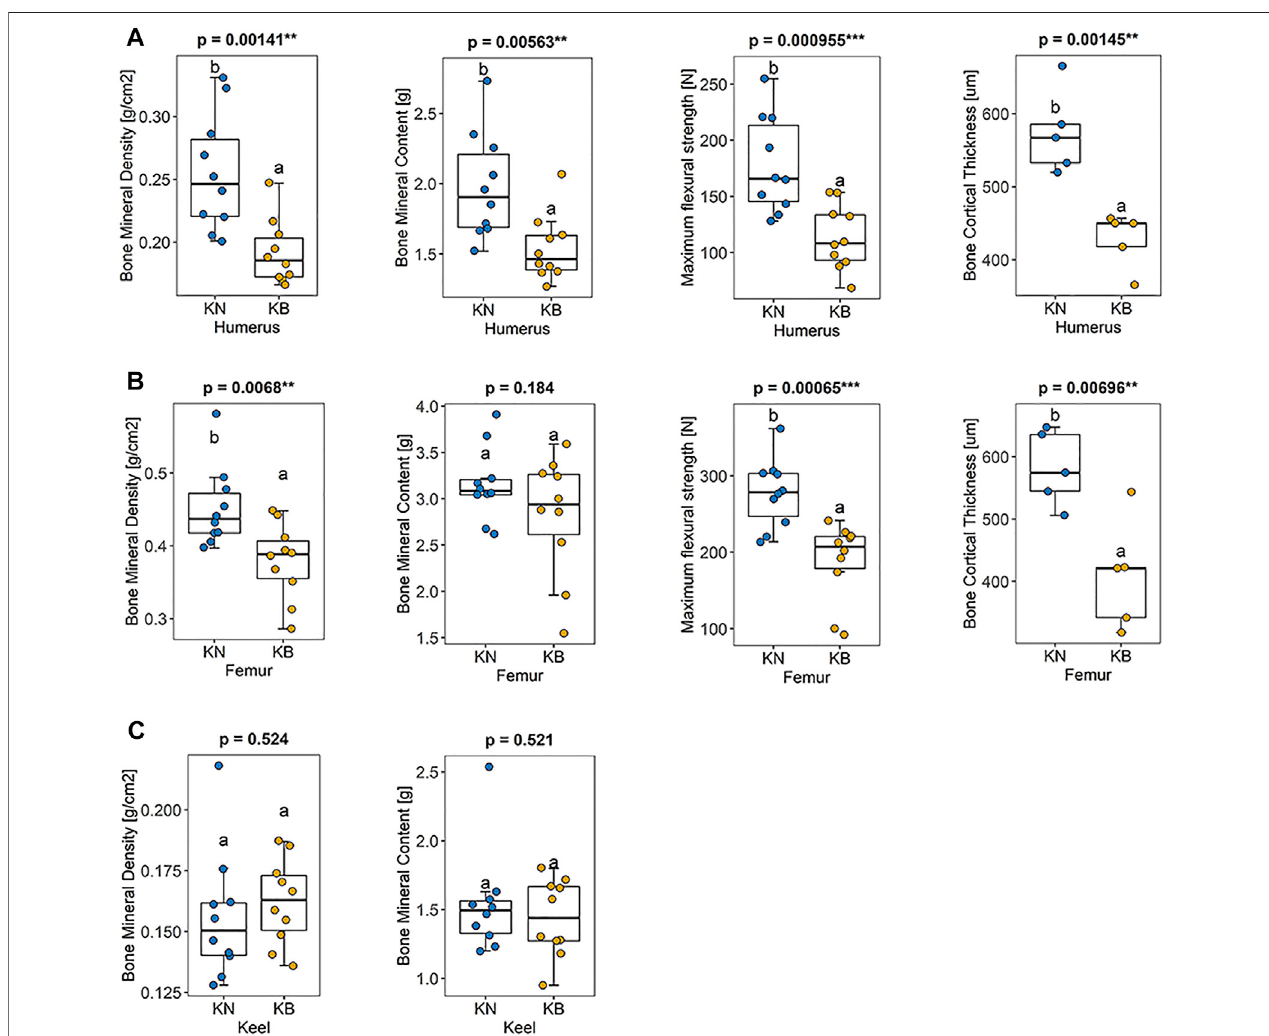
FIGURE4| Boxplotsofbonemineraldensity,bonemineraldensity,bonestrength,andbonecorticalthicknessinKNandKBchickengroups (A) Boneindexofthe humerus (B) bone index of the femur, and (C) bone index of the keel.